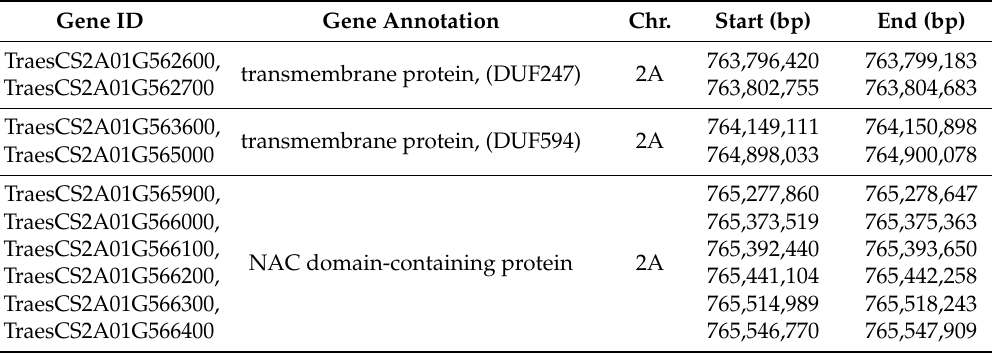
Figure 5. ( A ) Summary of genome-wide association scans for the subpanel of wheat genotypes (183) which analyzed by using the 90K iSELECT Infinium array, the 35K Affymetrix SNP array and the 135K Affymetrix SNP array for each year (2015/2016/2017) and BLUEs. The horizontal red color line indicated the threshold of − log 10 ( p -value) of 3. ( B ) Quantile-quantile scale representing expected versus observed − log 10 ( p -value). Table 1. Potential candidate genes underlying GFeC trait in